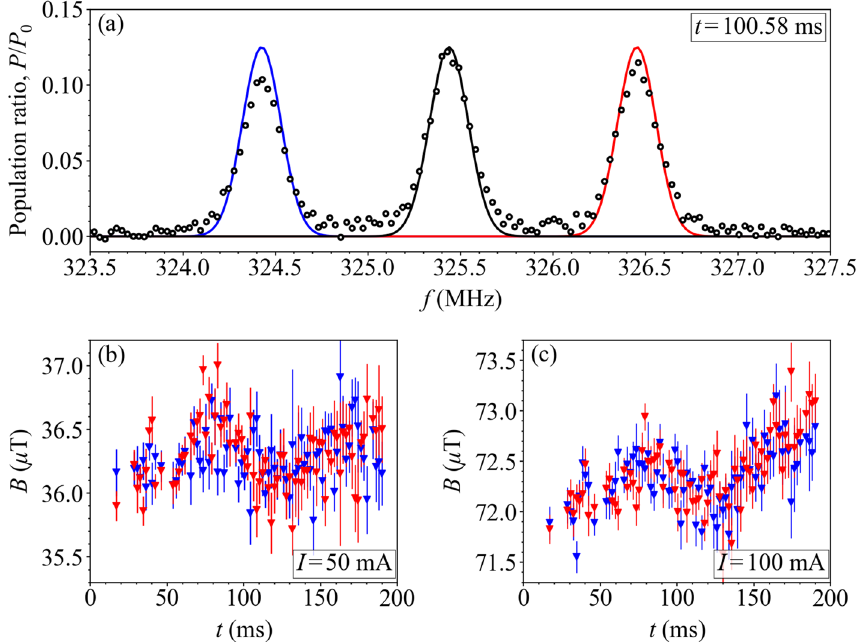
Figure 9. ( a ) Population ratio, P / P 0 , of the 87 Rb 5 2 S 1 / 2 | F = 1 � ground state as a function of Raman frequency, f , at a drop time t = 100.58 ms (position z = 18.5 mm), with a Raman pulse length of 4 µ s and frequency step of 30.30 kHz under axial magnetic field generated by the uniform axial B z field coil at current I = 50 mA. The data is shown with 133 points and the Lorentzian fits to the ω − 1, − 1 , ω 0,0 , ω 1,1 resonances are highlighted (blue, black, red). ( b , c ) Measured total magnetic field, B , calculated from the B − 1 (blue) and B 1 (red) transitions scanned at 78 points during the atomic cloud drop at bias coil currents: ( b ) I = 50 mA and ( c ) I = 100